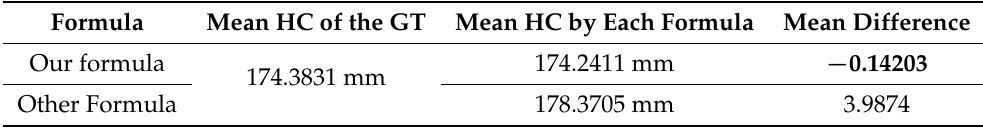
Table 3. Comparing two HC measurement formulas with the HC ground truth using the mean